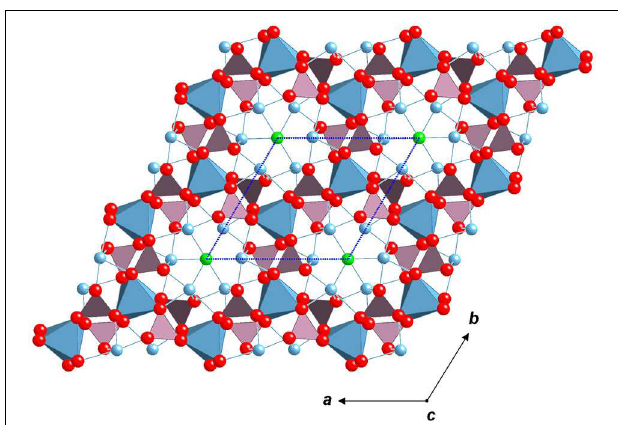
FIGURE 1 | Apatite structure, project on to the (001) plane. The thin dashed blue lines highlight the unit cell. Red ball are oxygen, light blue polyhedrons are Ca(I) cations, the light blue balls are Ca(II) cations, the green balls are channel anions, the purple tetrahedrons are X site cations. The thin light blue lines highlight